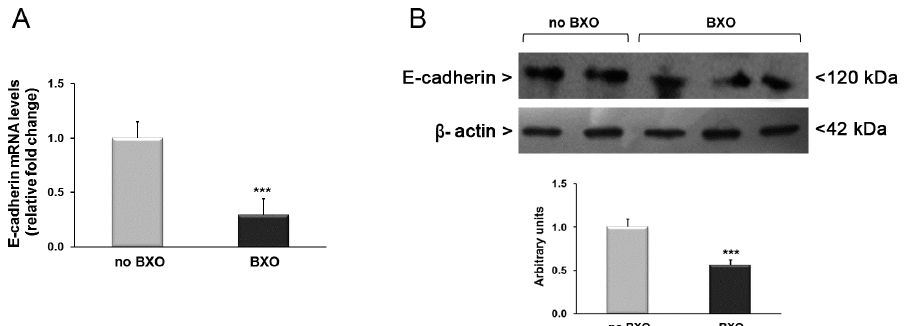
Figure 4. Analysis of expression levels of E-cadherin in foreskin tissues from patients with ( n = 15) and without ( n = 15) BXO. ( A ) Results obtained by real-time PCR are expressed as relative fold change compared with patients without BXO. Error bars represent standard error of the mean; ( B ) Western blot analysis of E-cadherin protein amounts. This picture is representative of foreskin tissues from patients with and without BXO. A representative densitometric analysis of all samples is also reported ( bottom ). The results are expressed as mean ± SEM. *** p < 0.0001 significant differences in comparison with patients without BXO.